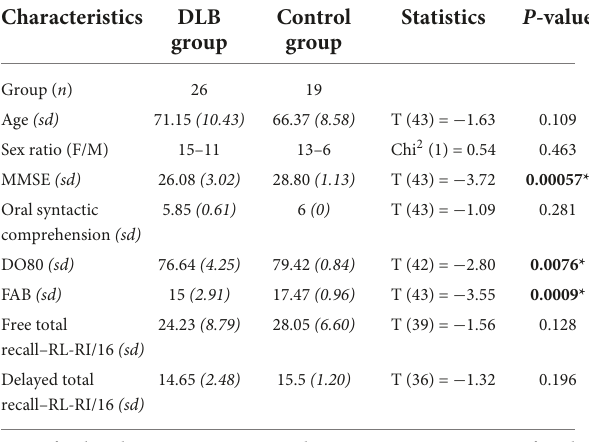
TABLE 1 Comparison of participants’ characteristics between the DLB and control groups.